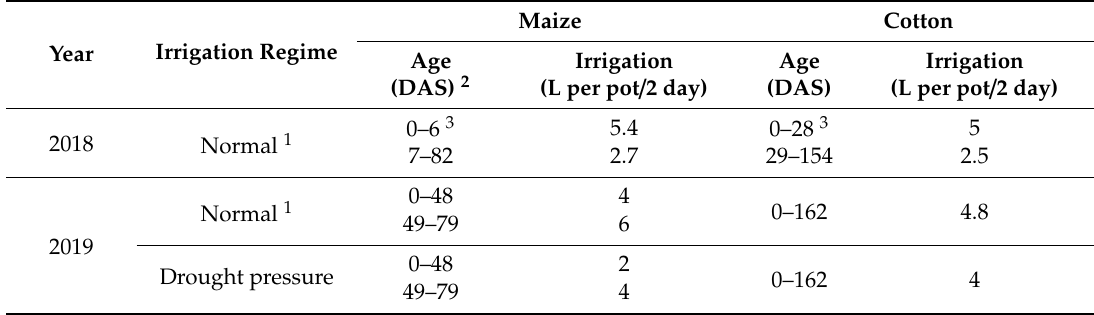
Table 1. Water irrigation regime during the full-growth season pot experiments (2018 and